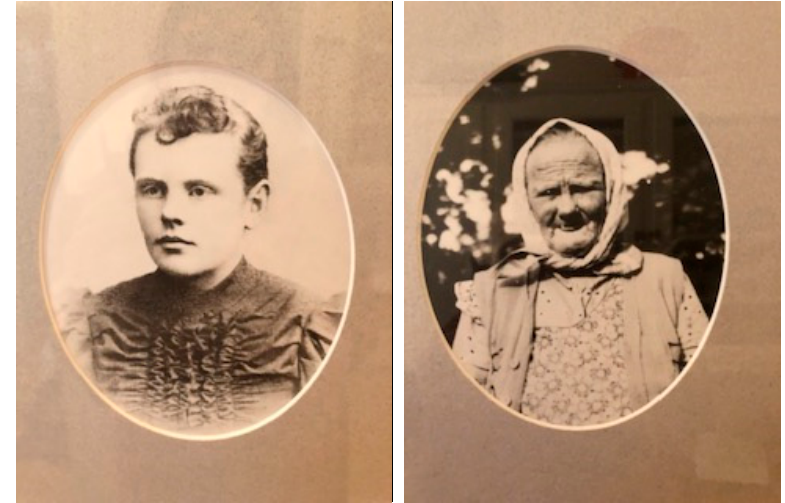
Figure 5. Our great-grandmother, Ellen-Maria Ekström, is the shared ancestor who brought us both together. She pre-dated us by four generations. We learned about our connection in the following